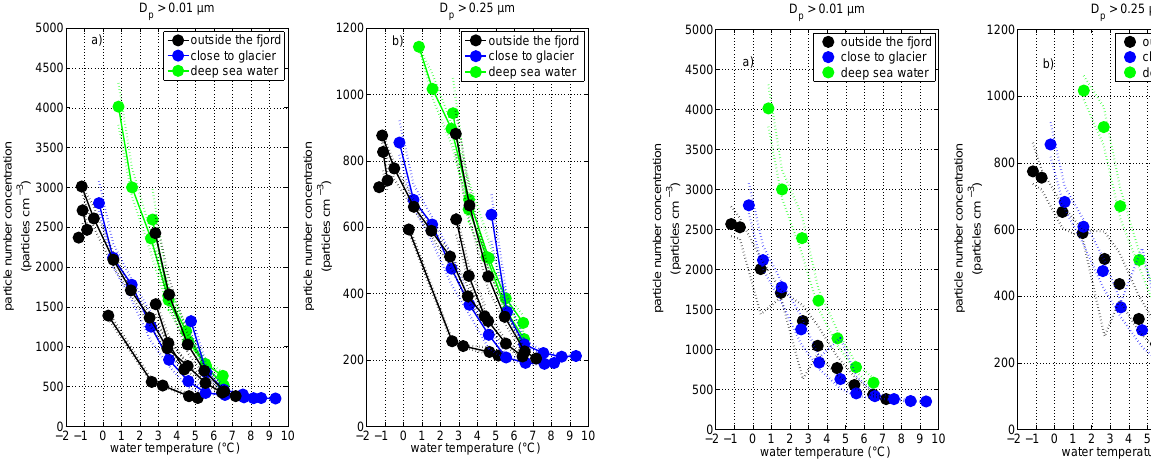
Fig. 5. Medians of the particle number concentration as a func- tion of water temperature for different sampling locations. Dashed lines represent the 25th and 75th percentiles. (a) Measurements for particles with D p > 0 . 01µm. (b) Measurements for particles with D p > 0 . 25µm. Note the different